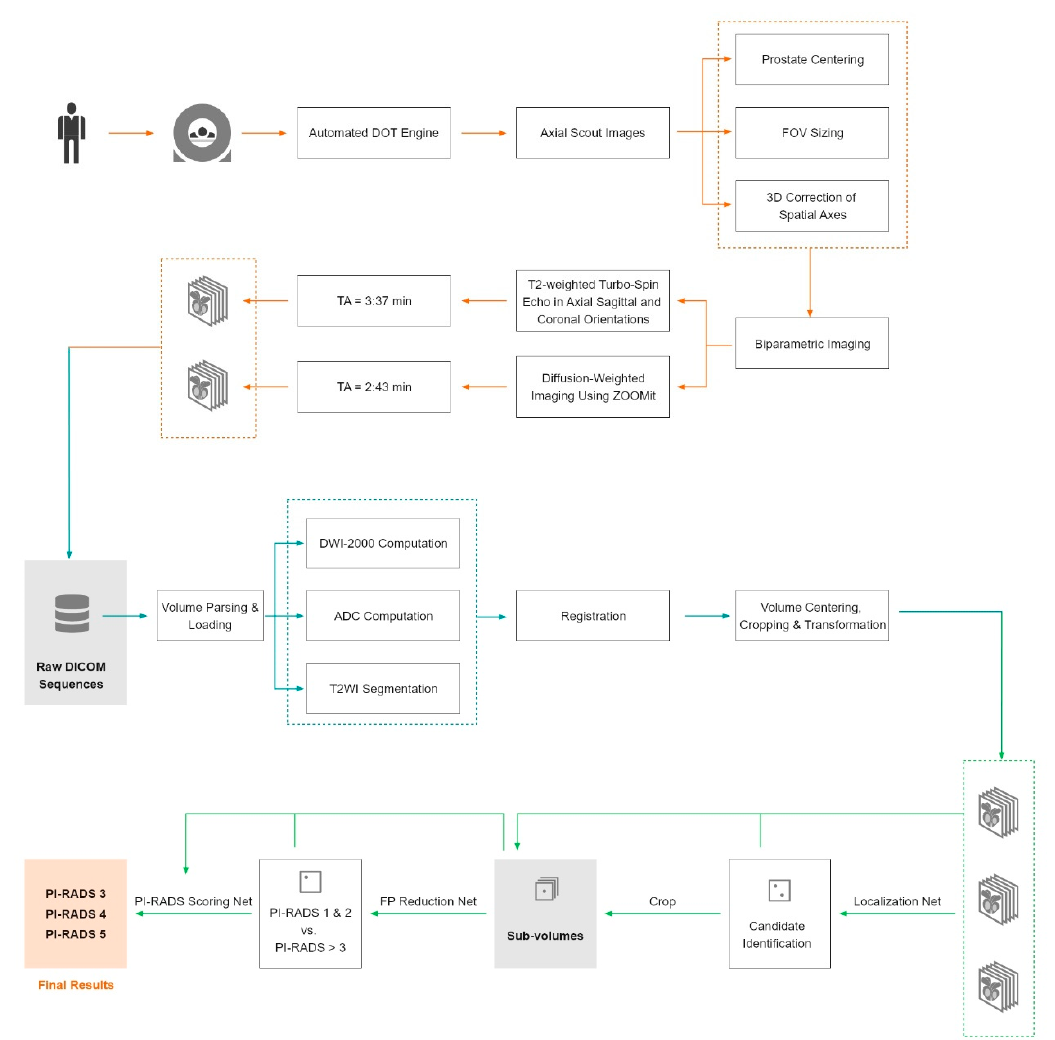
Figure 2. Image acquisition workflow using the automated day optimizing throughput (DOT) engine and biparametric imaging (in orange) as well as the deep learning architecture with the preprocessing pipeline (in blue) and the deep-learning-based lesion detection and classification component (in green). DOT = day optimizing throughput, FOV = field of view, 3D = three-dimensional, TA = time of acquisition, DICOM = Digital Imaging and Communications in Medicine, ADC = apparent diffusion coefficient, FP = false positive, PI-RADS = Prostate Imaging Reporting and Data System.